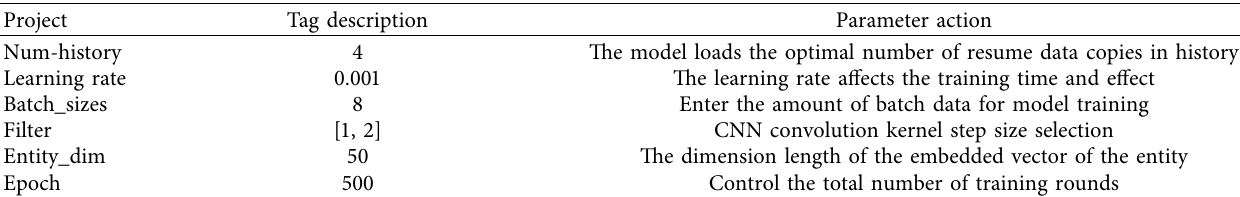
Table 2: The main parameters of the person-post matching model.